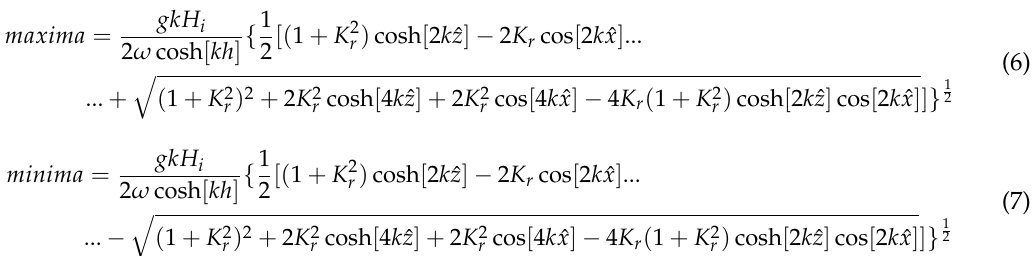
Figure 2. Schematic representation of the cross section of an incident and reflected wave in deep water where u inc and w inc are the horizontal and vertical velocity components for the incident wave, u refl and w refl are the horizontal and vertical velocity components for the reflected wave, u res and w res are the horizontal and vertical velocity components for the resultant wave, d is the distance of x to the reflective boundary, x is the horizontal distance, z is the vertical depth from the still water surface and θ is the tilt of the maxima axis to the horizontal